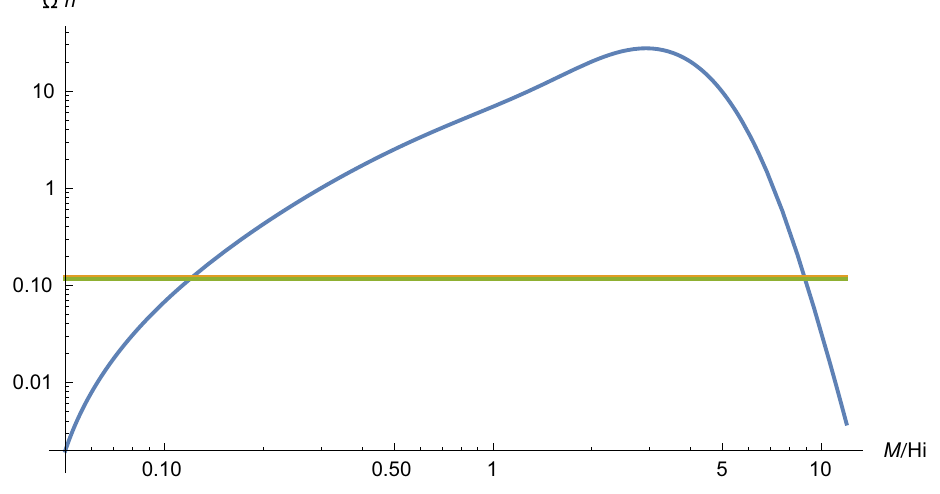
T reh = 3 · 10 9 GeV. The right amount of cold DM: (cid:22) 3 / 2 h 2 = (cid:22) 2 = 0 . 11 (in orange) is generated when the Polonyi mass is DM h M A ≈ 2 m 3 / 2 = ( 1 . 54 ± 0 . 2 ) × 10 13 GeV that is compatible with the Polonyi mass inferred from Starobinsky inflation and reheating in Eq. (56)